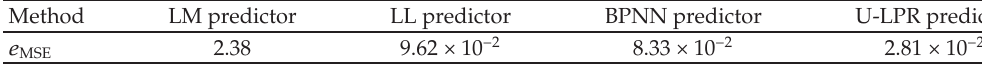
Table 1: MSE of four kinds of predictors.